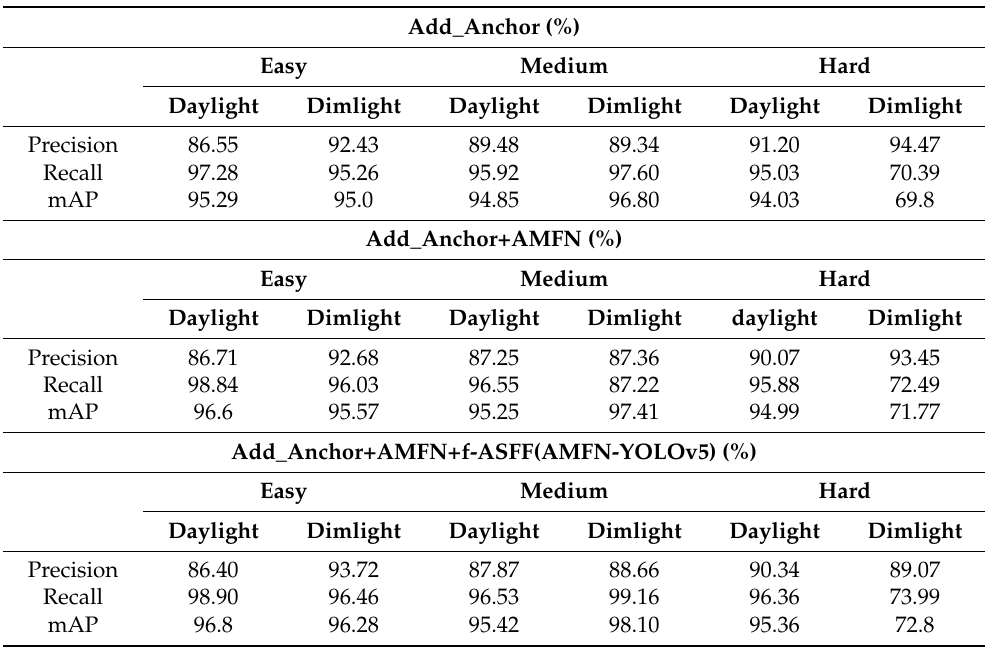
Table 4. Comparison with the fusion experiment.